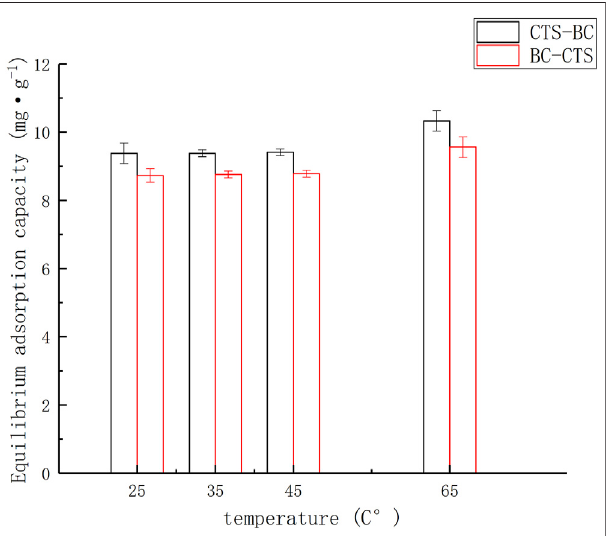
FIGURE 2 | Effect of reaction temperature on Pb 2+ adsorption.